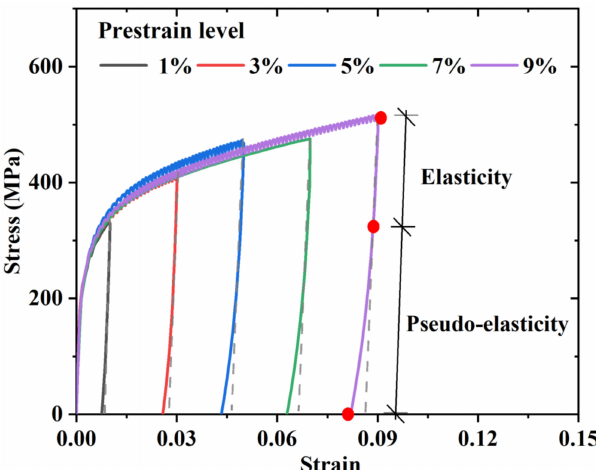
Figure 6. Pseudo-elasticity phenomenon of Fe-SMA.